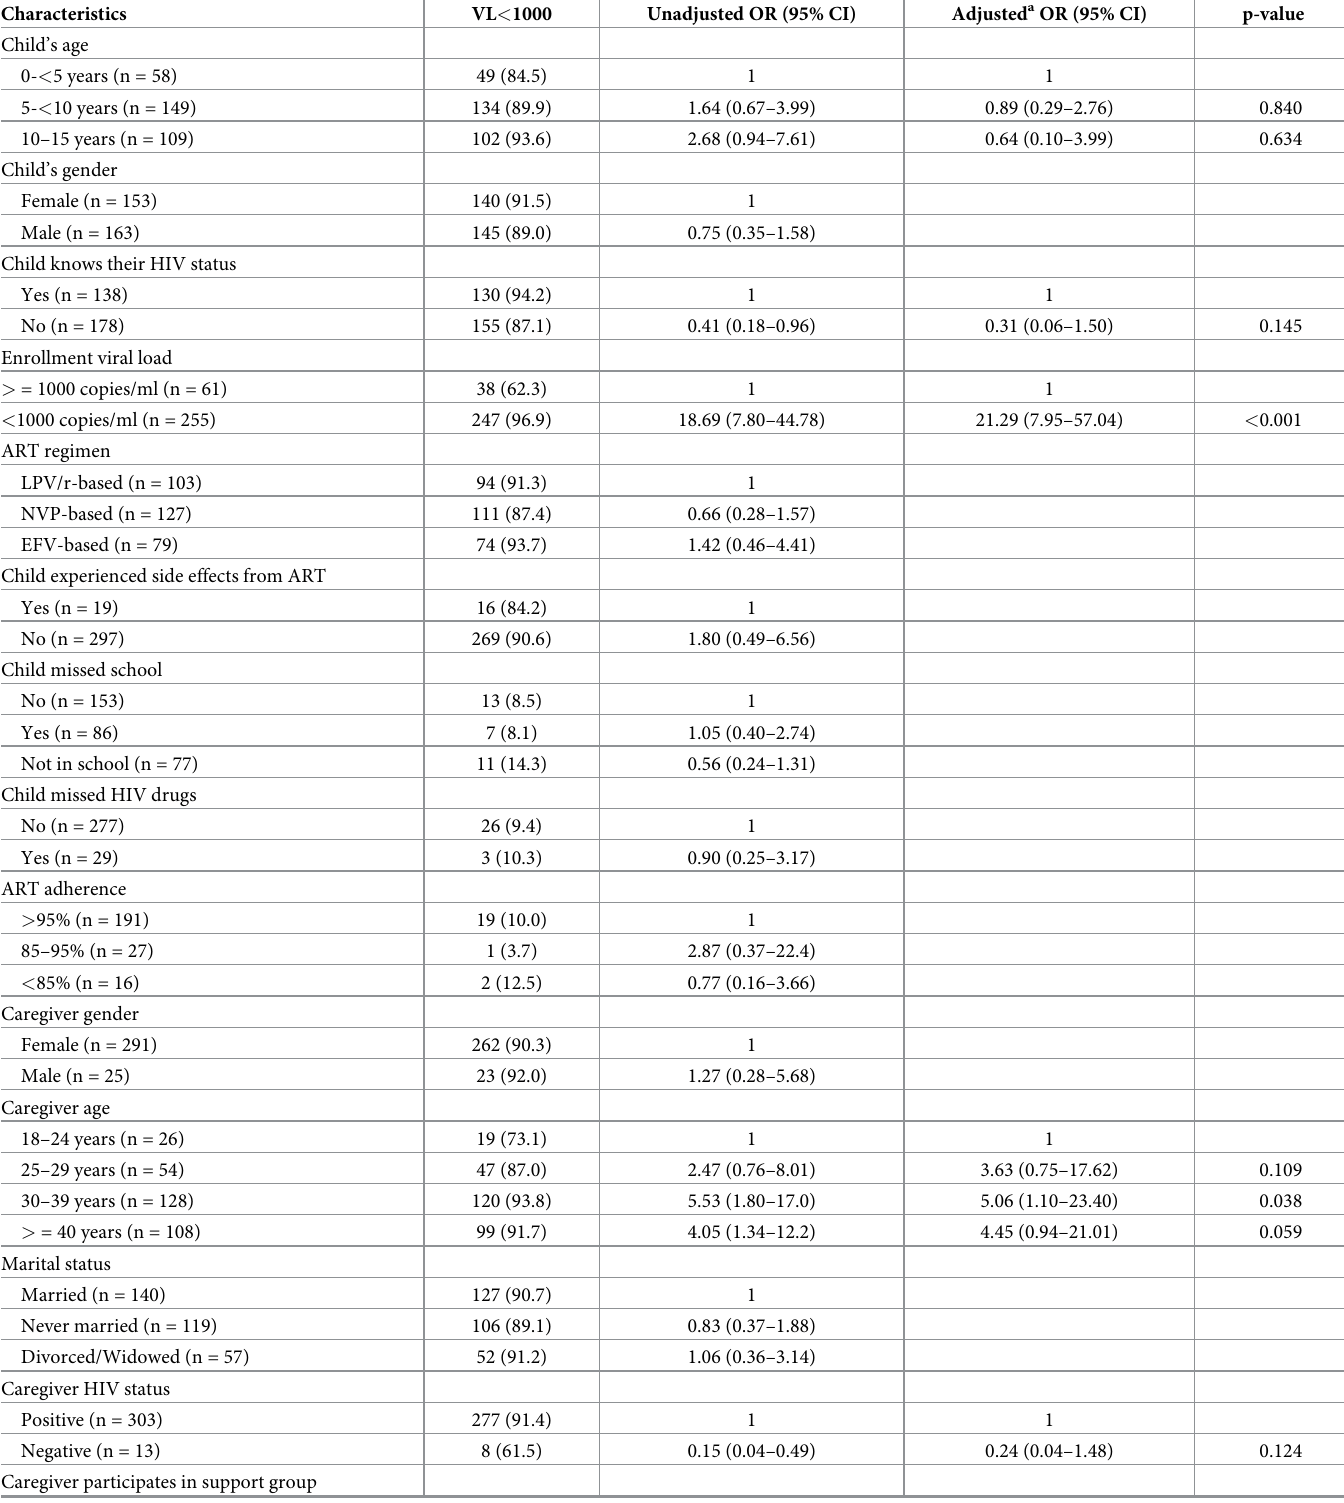
Table 4. Factors associated with viral suppression at 12 months.